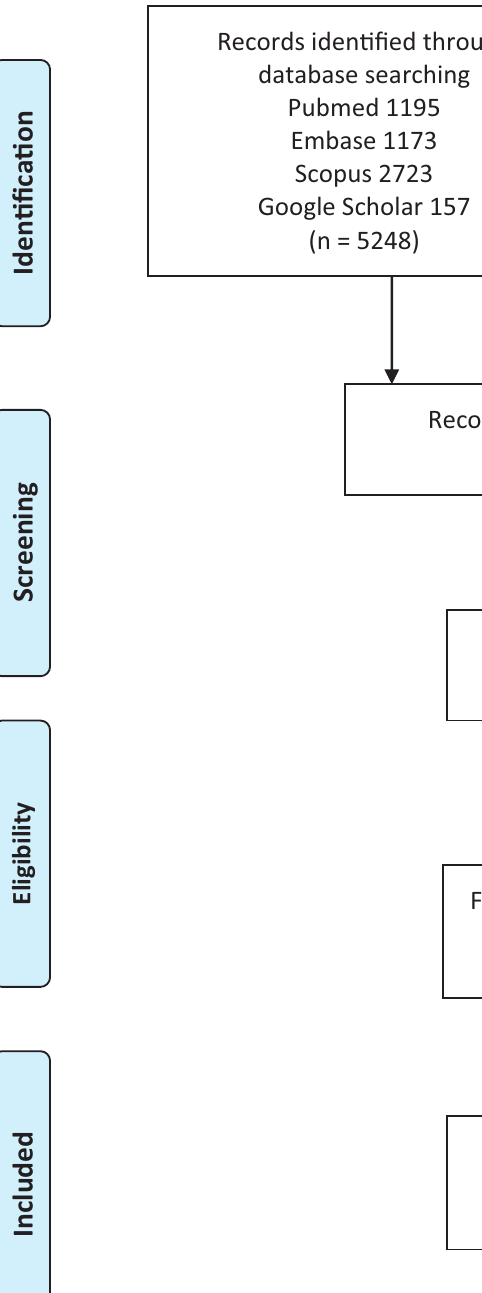
Figure 1. PRISMA flow chart of the screened and assessed